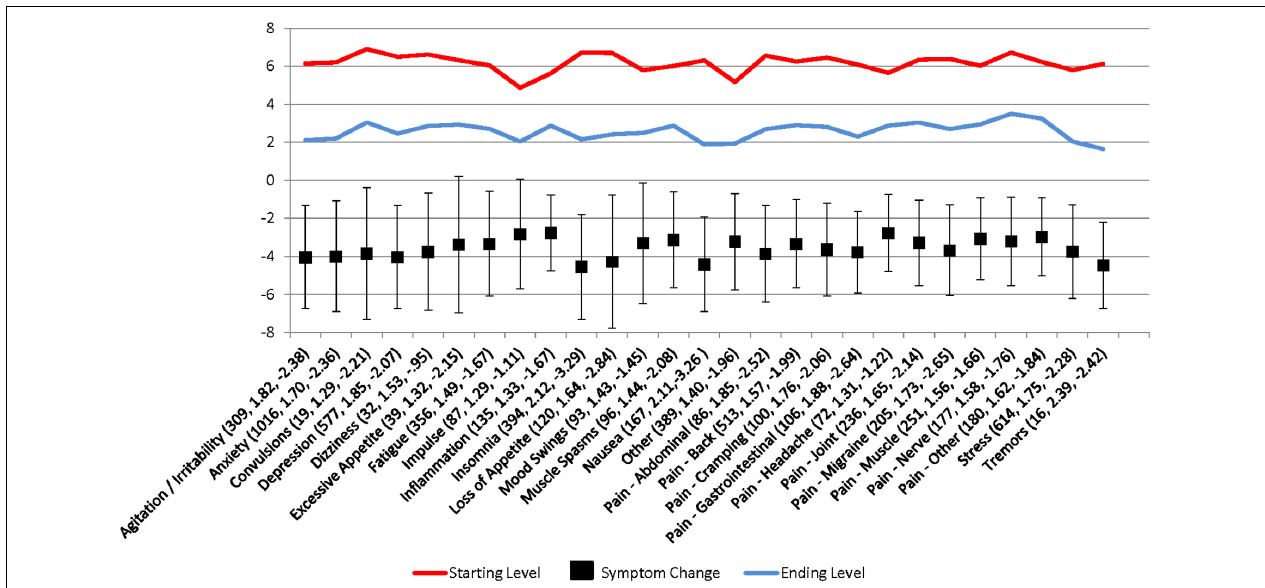
FIGURE 1 | Patient-reported symptom relief following medical cannabis consumption. Values in parantheses are the symptom category sample size, Cohen’s d, and adjusted symptom relief score (symptom relief + number of negative side effects), respectively.